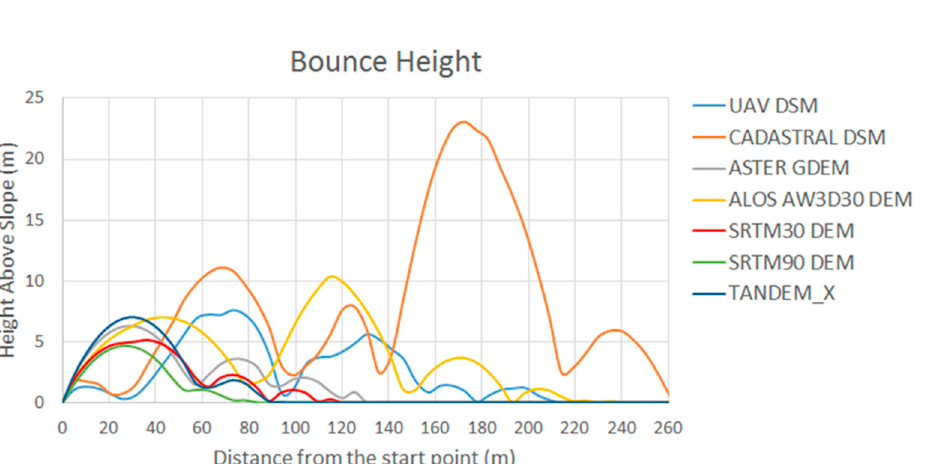
Table 7. Total kinetic energy distribution at x = 130 m for the 2nd slope profile. Slope Profile 2